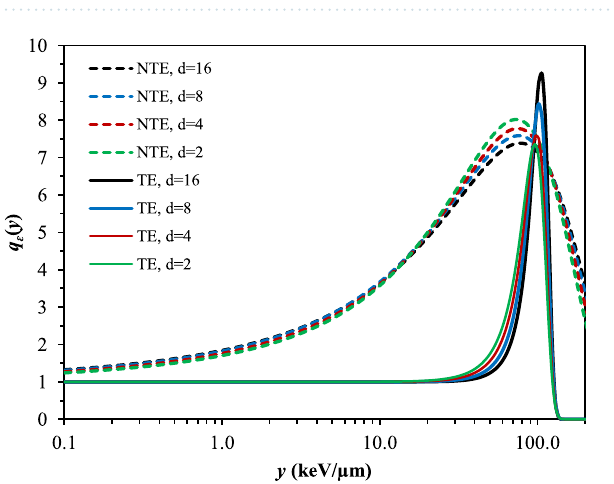
Figure 1. Calculated dose-normalized distributions of microdosimetric energy deposition as a function of lineal energy ( y ) for different ion types (energies given in the text) and different sized spherical target diameters ( d = 2, 4, 8, or 16 µm). Normalized y × d ( y ) spectra are shown, such that equal areas under the y × d ( y ) curve between any two y values correspond to equal doses 38 . The spectra for the same ions, plotted using a linear y-axis scale, are shown in Supplementary Fig. 2 to improve visualization of different spectrum components.